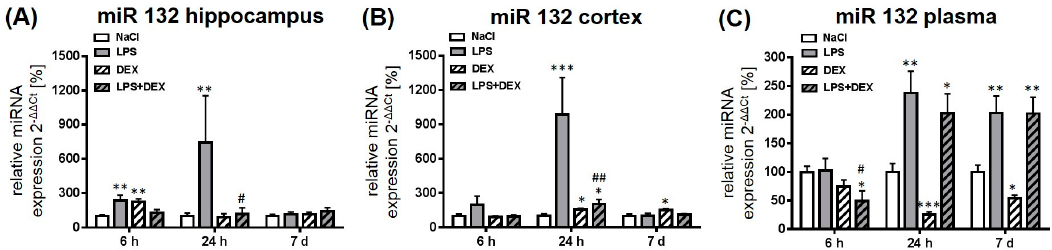
Figure 3. Representation of miR 132 expression after LPS and dexmedetomidine treatment in the hippocampus ( A ), cortex ( B ), and plasma ( C ). Results are shown as mean ± SEM ( n = 6–8 per group). Data are normalized to levels of saline-treated rats (control = 100%). * p < 0.05, ** p < 0.01, and *** p < 0.001 represent the difference compared to saline-treated groups. # p < 0.05 and ## p < 0.01 represent the difference between LPS and LPS in combination with dexmedetomidine-treated groups.